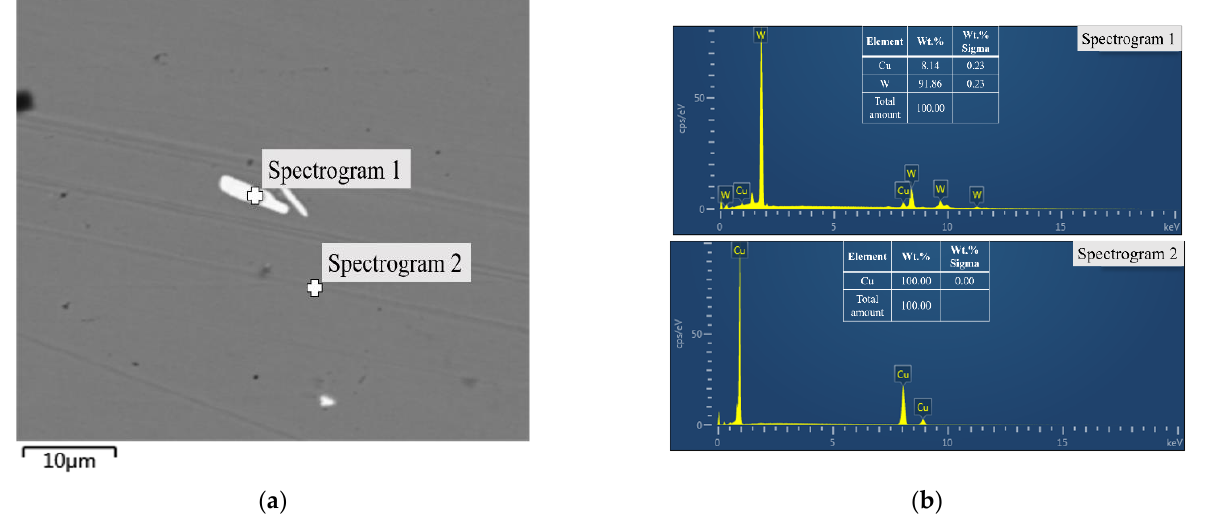
Figure 6. The cross-sectional SEM image ( a ) and EDS analysis ( b ) of W – Cu composite ( J = 2 A/dm 2 , f = 1500 Hz, d r = 5% and d f = 20%).